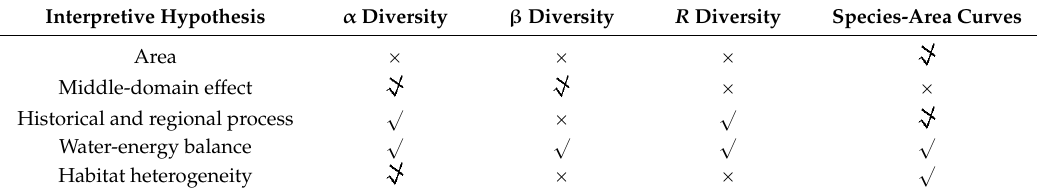
Table 5. Comparison of different hypotheses to explain the elevation-related patterns of plant species diversity in Baima Snow Mountain. α diversity, species richness of transects; β diversity, species turnover rate between pairs of neighboring transects; r diversity, total species recorded in all transects of each (eastern or western) aspect of the BSM; × , rejected; √, supported; , partially supported (or rejected).